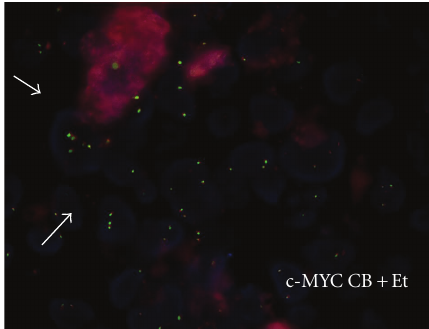
Figure 5: To assess whether multiple MYC signals relied on MYC gene amplification or on chromosomal 8 polyploidy, a centromeric probe for chromosome 8 was used. Our results indicated the presence of multiple signals for chromosome 8 in cells treated with E. tirucalli , consistent with a polysomy of chromosome 8. Arrows indicate cells with multiple chromosome 8 and MYC